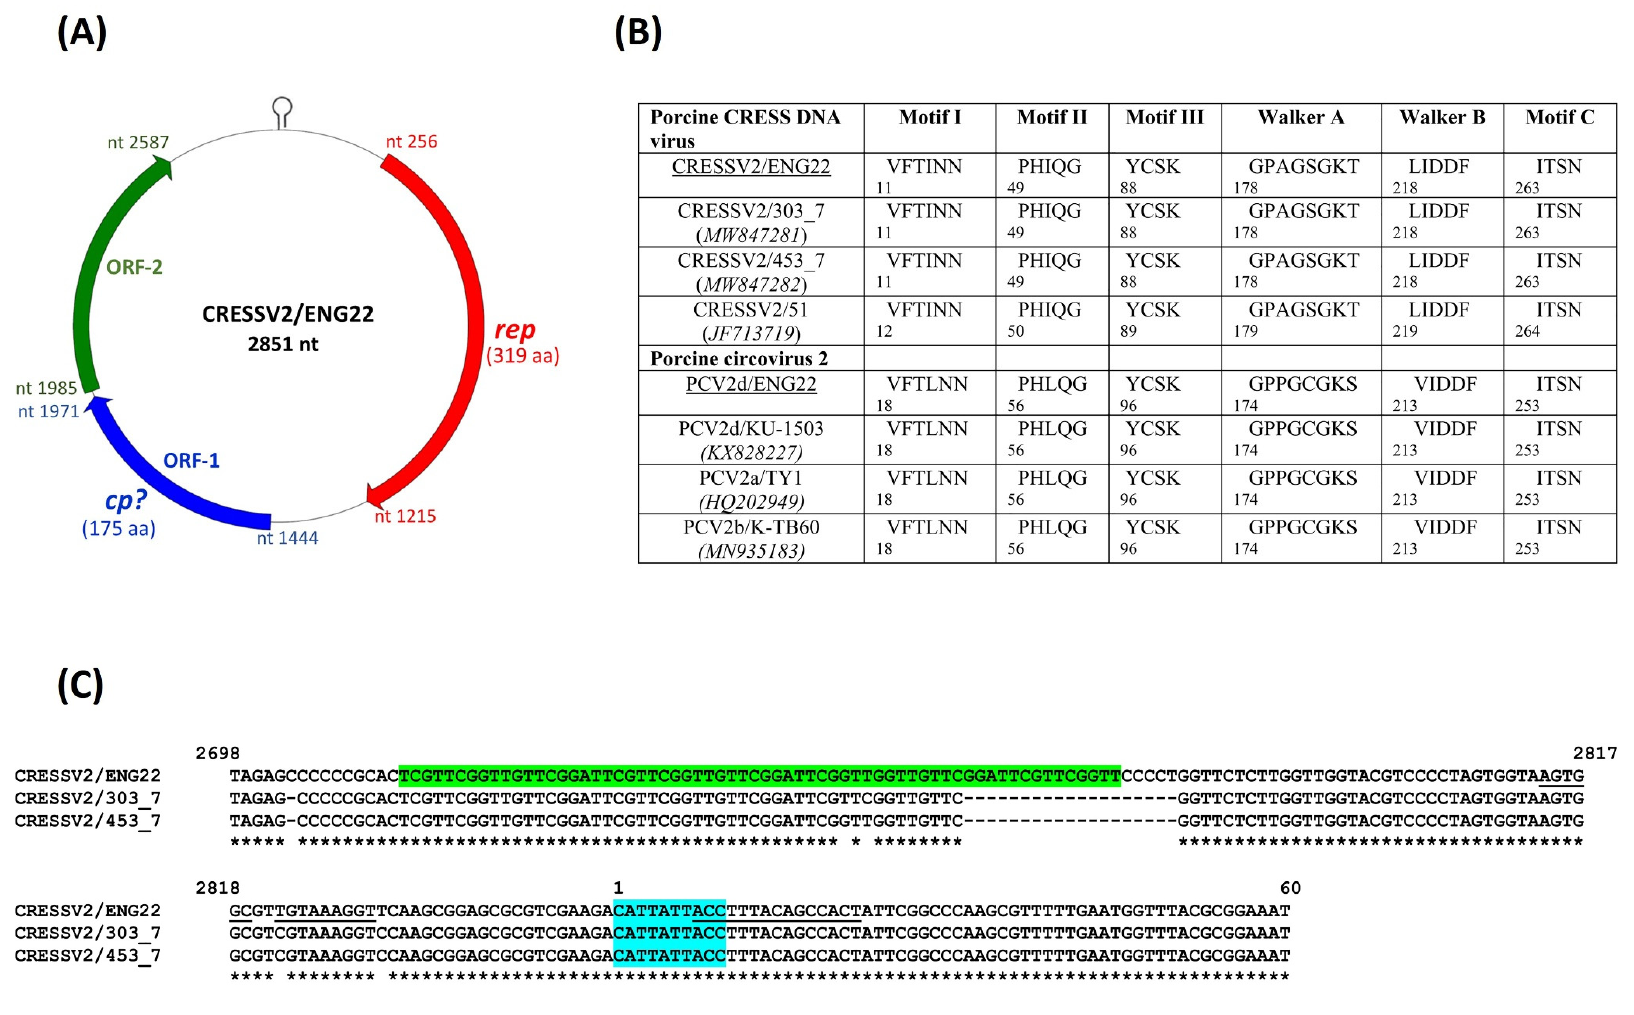
Figure 3. Genome organization of porcine-associated circular Rep-encoding single-stranded (CRESS) DNA virus CRESSV2/ENG22. The nonanucleotide motif at the apex of a putative stem-loop structure (marked in the large intergenic region) and the three predicted open reading frames (ORFs) were located on the